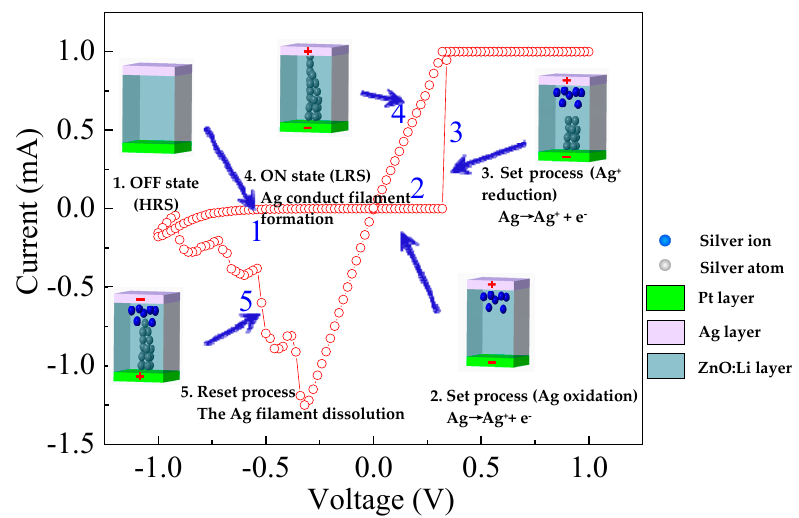
Figure 11. Schematic related to the formation and rupture of the metallic Ag filament in LZO-5 devices.